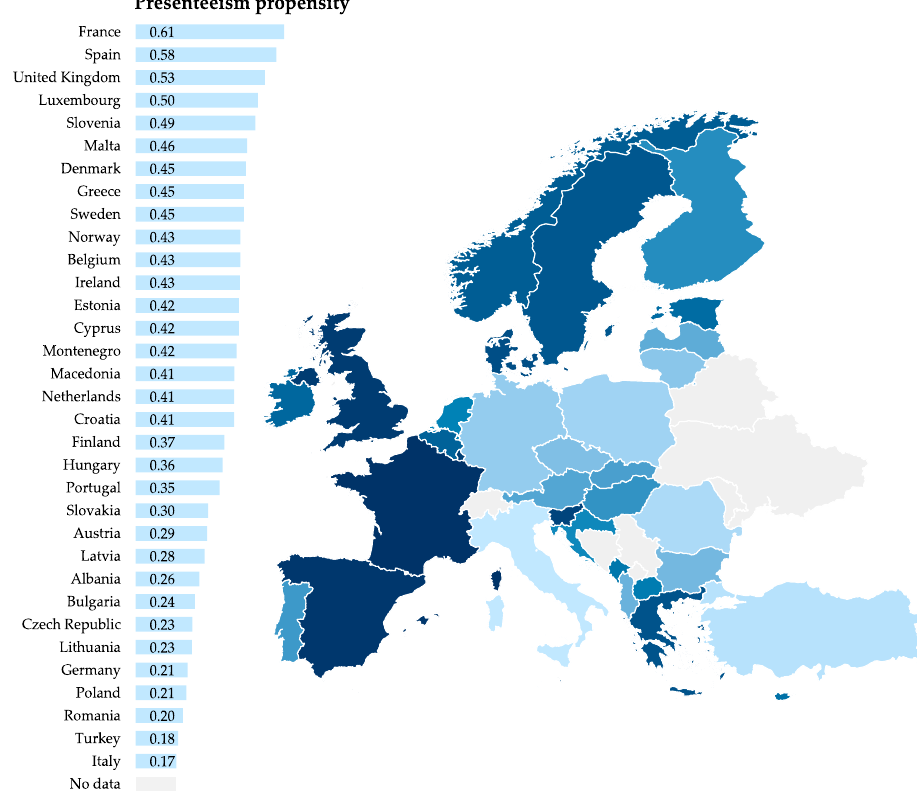
Figure 1. Means of presenteeism propensity in 33 European countries (2015) adjusted for sex, age, job tenure, working hours, occupation and working sector.